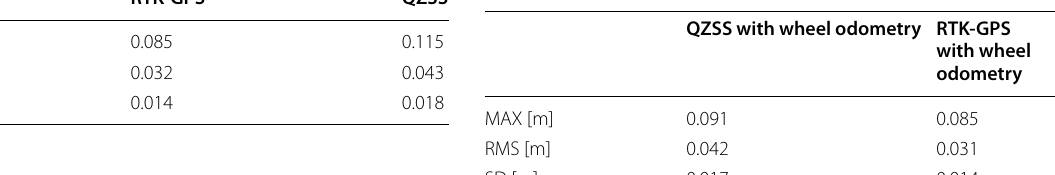
Table 1 Differences between the positions measured by the global navigation satellite system (GNSS) and the robotic total station